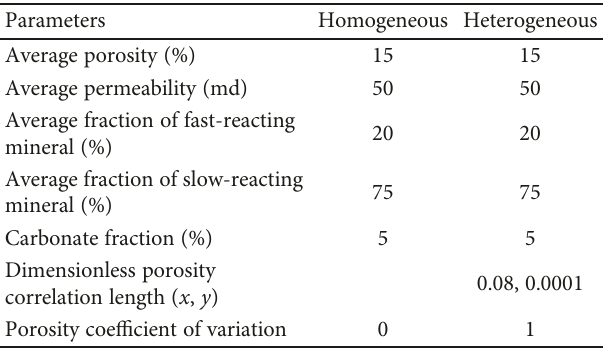
Table 2: Formation